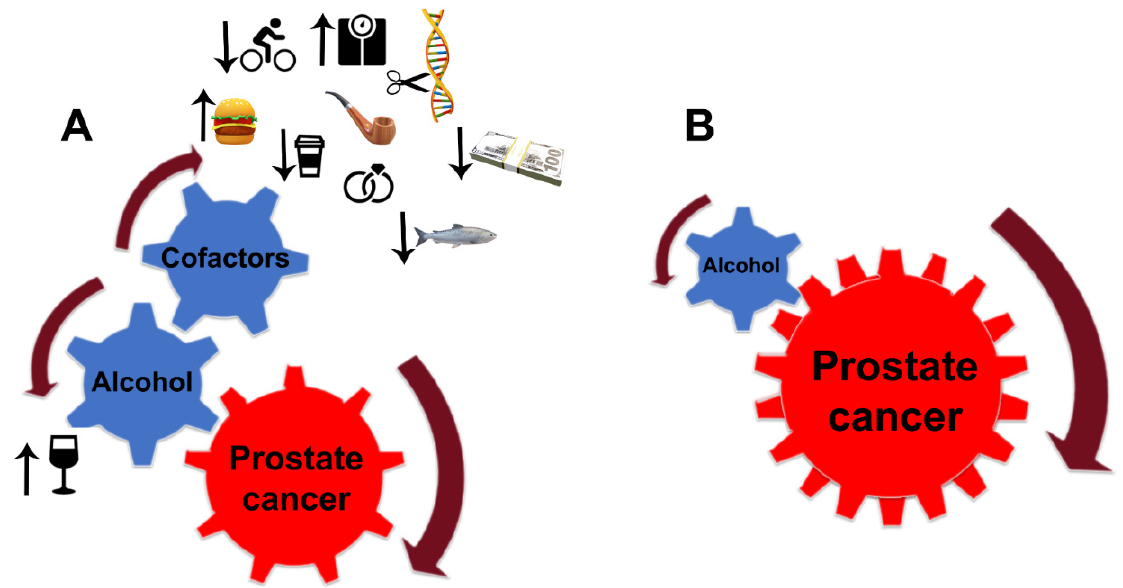
Figure 5. Alcohol interference in the development and progression of PCa. ( A ) Alcohol is a critical player and driver of prostate carcinogenesis. The carcinogenic effects of EtOH and its metabolites are magnified by multiple cofactors, such as obesity, smoking, excessive high-fat and red meat diet, low-level consumption of fish, caffeine, and linoleic acid, low physical activity, SNP of alcohol-related genes, and family history of PCa. Additional factors may include income and marital status: unmarried patients with an unstable financial situation are at higher risk of PCa. ( B ) In patients diagnosed with PCa, alcohol’s contribution to prostate tumor progression does not require cofactors. EtOH metabolites are sufficient to drive tumor growth and raise the metastatic potential of cancer cells.